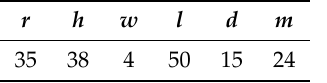
Table 1. Optimized values of the antenna geometrical parameters (in mm).